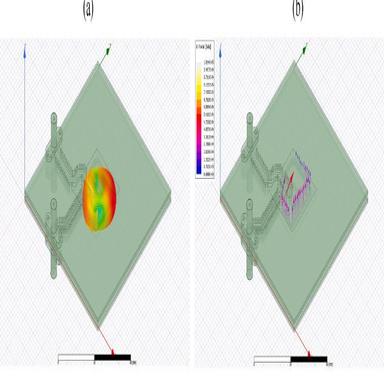
Simulation results for paired fixtures: (a) S-parameters in the 0.2 GHz~6 GHz frequency band; (b) radiation pattern; (c) 3D pattern; (d) E field; (e) H field; (f) current density (top view).